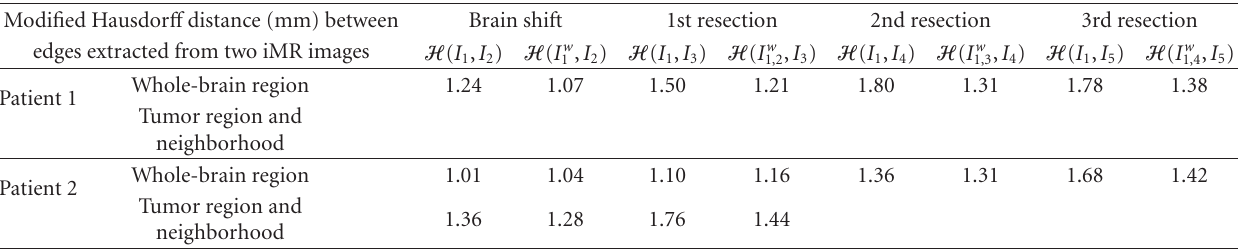
Table 2: Values of H ( I 1 , I k +1 ) and H ( I w , I k +1 ), k = 1, ... ,4, for each deformation modeling based on a pair ( I k , I k +1 ) of two successive 1, k iMR images. In contrast with Table 1, I 1 is successively warped, rather than I k , for each deformation modeling. First value gives measure of similarity of images rigidly registered, while second value gives measure of similarity of images both rigidly and (subsequently) nonrigidly registered. For each I k , only the whole-brain region is taken into account for edge extraction. Modified Hausdor ff distance (mm) between Brain shift 1st resection 2nd resection 3rd resection edges extracted from two iMR images Whole-brain Patient 1